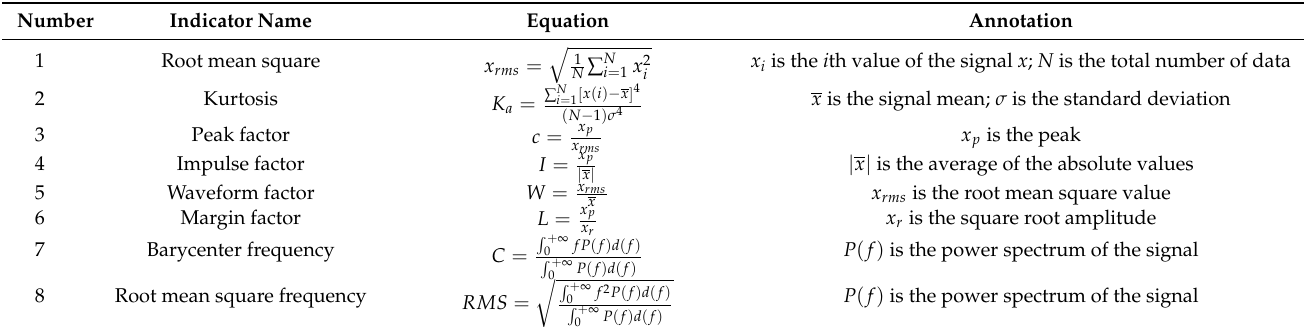
Table 3. Calculation equations of the time–frequency index.